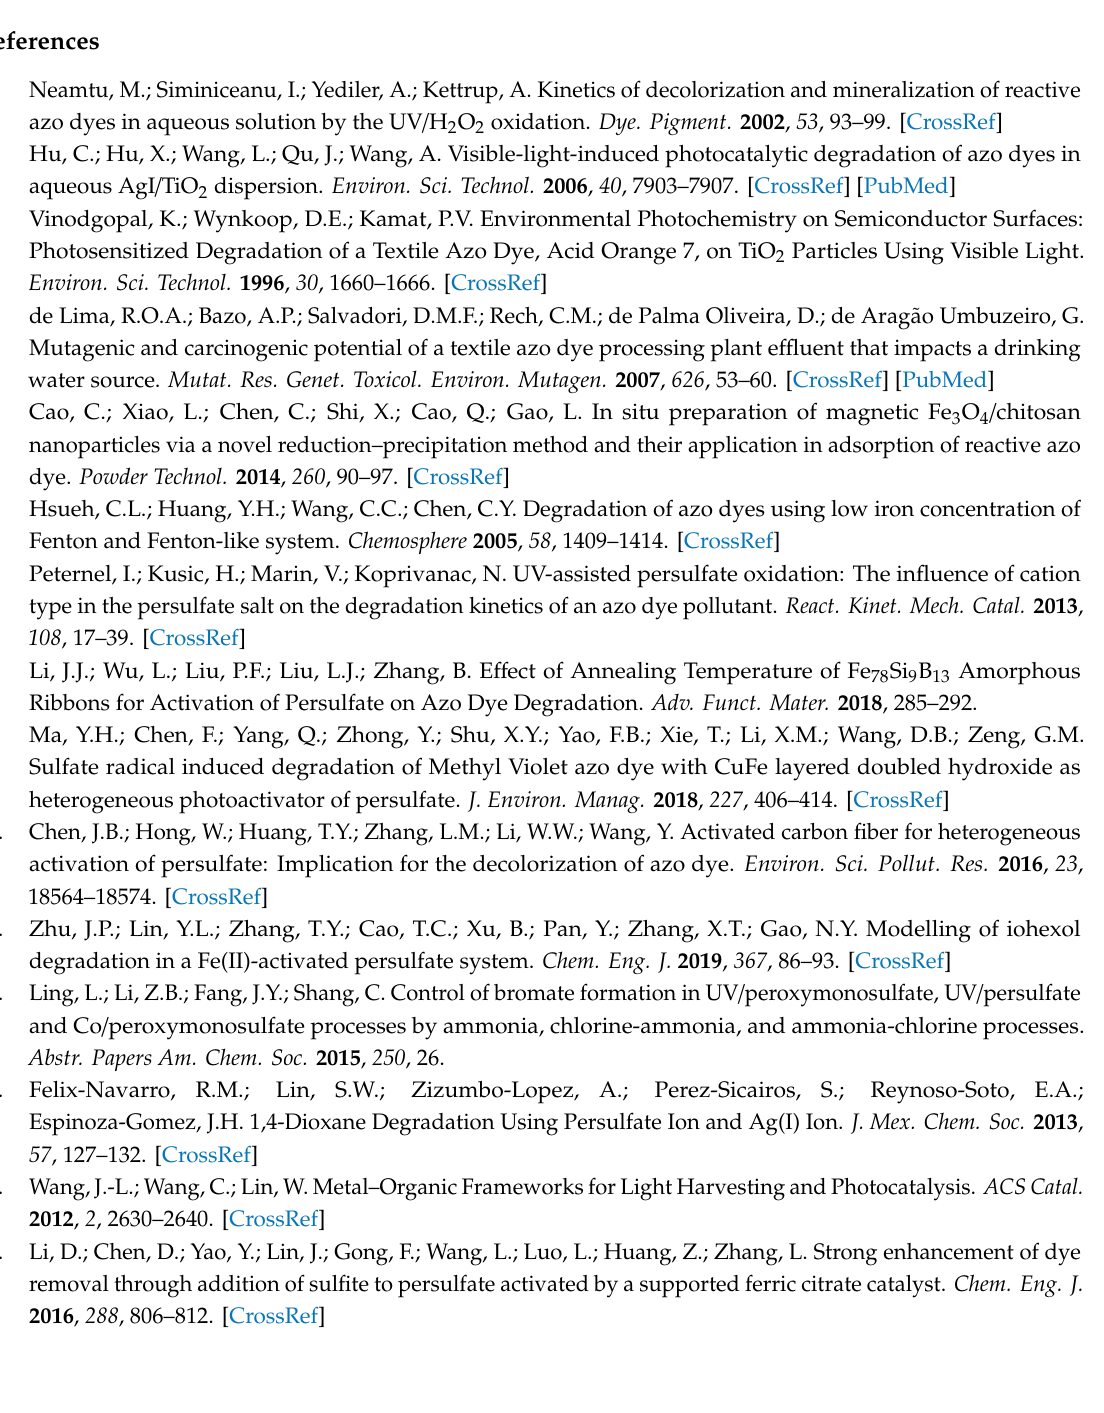
Figure S1: TEM image of M-0, Figure S2: TEM image of M-120, Figure S3: TEM image of M-170, Figure S4: TEM image of